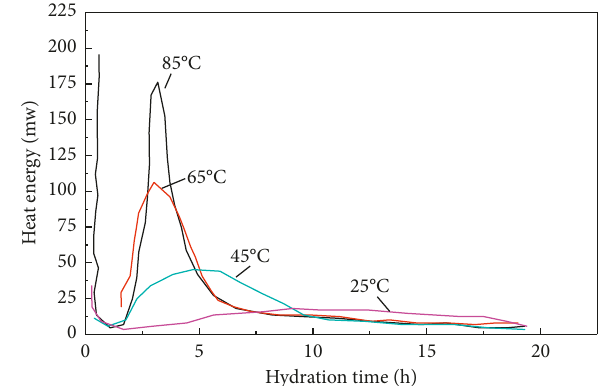
Figure 6: Influence of temperature on hydration process.